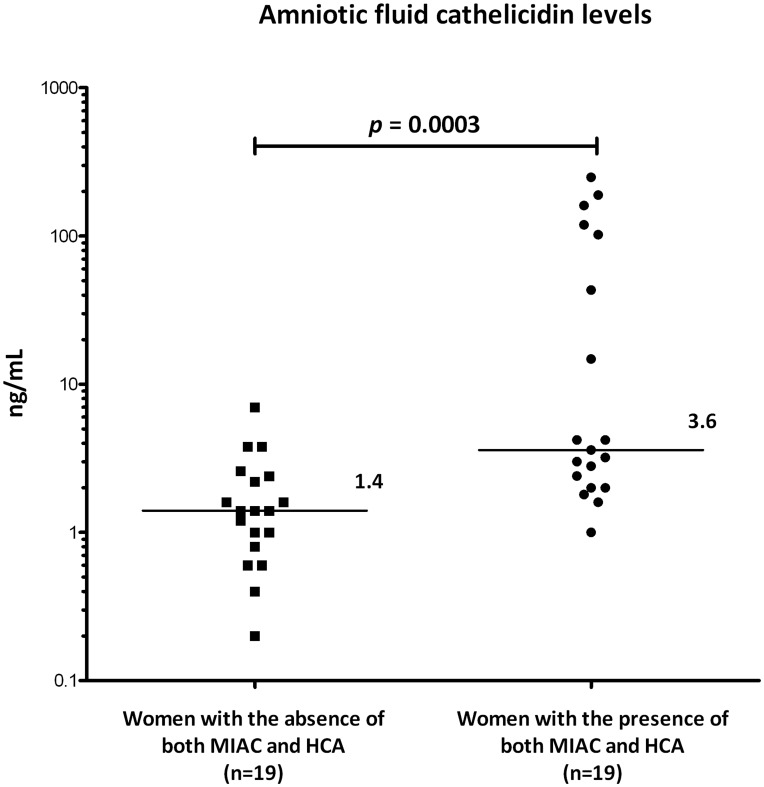
Verification of amniotic fluid cathelicidin levels.In concordance with the iTRAQ findings, women with confirmed MIAC and HCA enrolled in the exploratory phase had significantly higher amniotic fluid cathelicidin concentration than women in whom both conditions were ruled out. Cathelicidin levels were measured using a commercial ELISA kit. Values were evaluated using nonparametric Mann-Whitney U test. Graph represents individual values, horizontal bars indicate median values. Abbreviations: MIAC  =  microbial invasion of the amniotic cavity; HCA  =  histological chorioamnionitis.